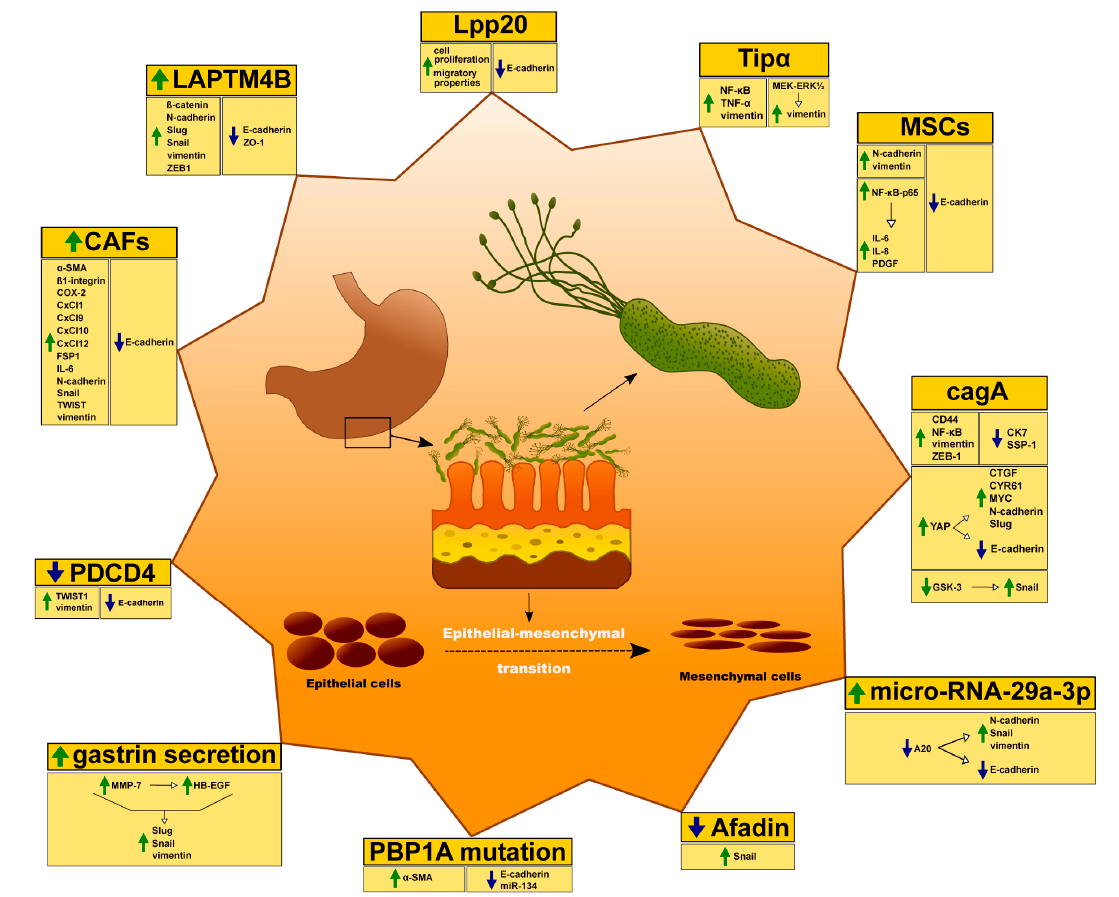
Figure 2. Possible mechanisms of the association between H. pylori infection and EMT.